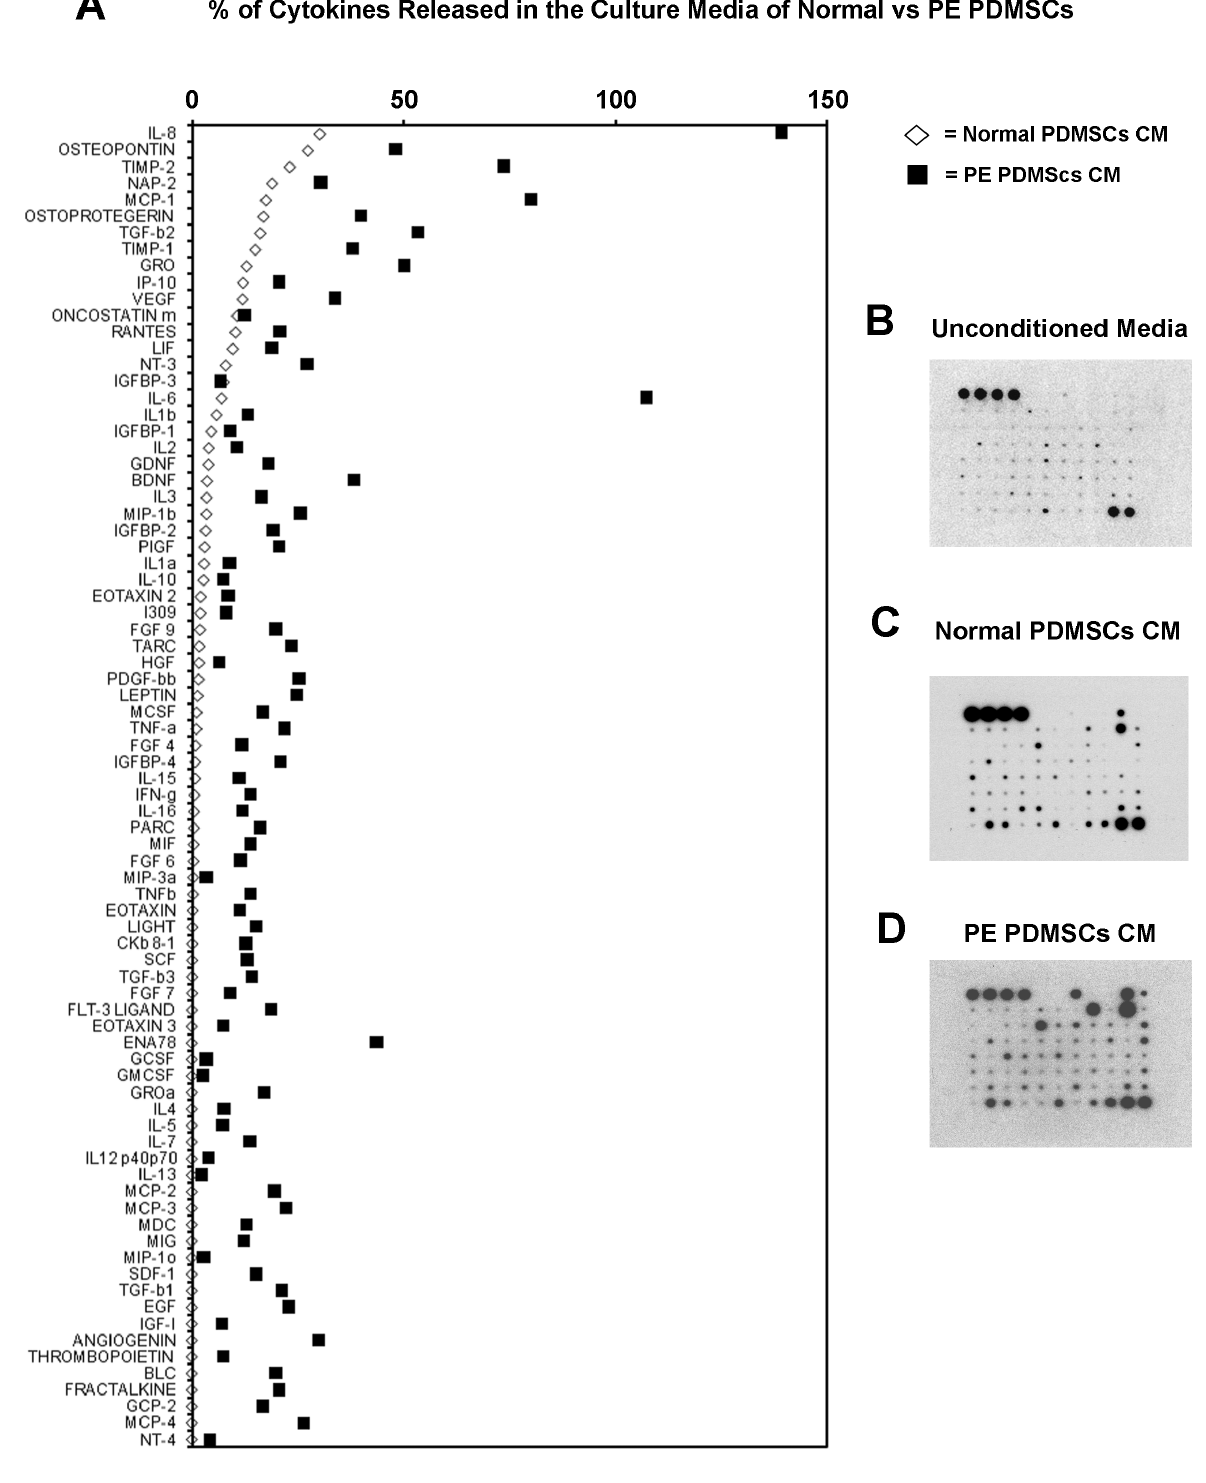
Figure 3. Expression of pro-inflammatory cytokines, chemokines and growth factors in control and PE PDMSCs conditioned media. A) Scatter plot showing increased release in the culture media of pro-inflammatory cytokines and chemokines (80 molecules analyzed) by PE relative to control PDMSCs. Each data point represent the average of four control media from normal PDMSCs (white squares) and four PE PDMSCs media (black squares) used for the analysis. B) Representative cytokine array blots of unconditioned media (upper panel) and media conditioned by control (middle panel) and PE (lower panel) PDMSCs.